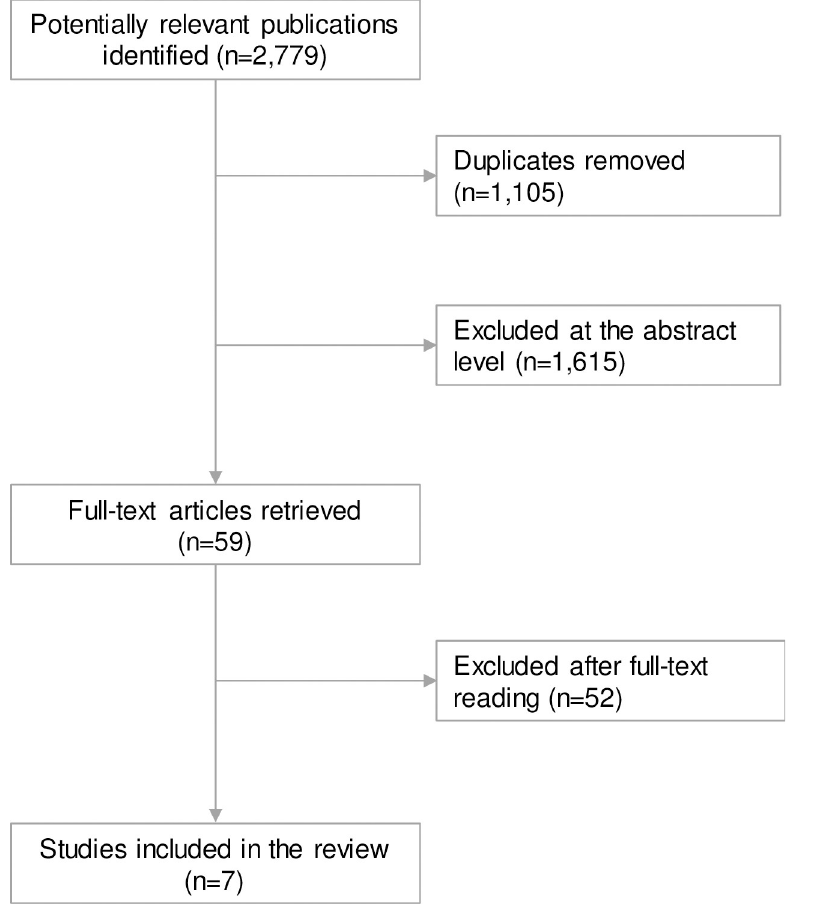
Fig 1. Flowchart of studies included in this systematic